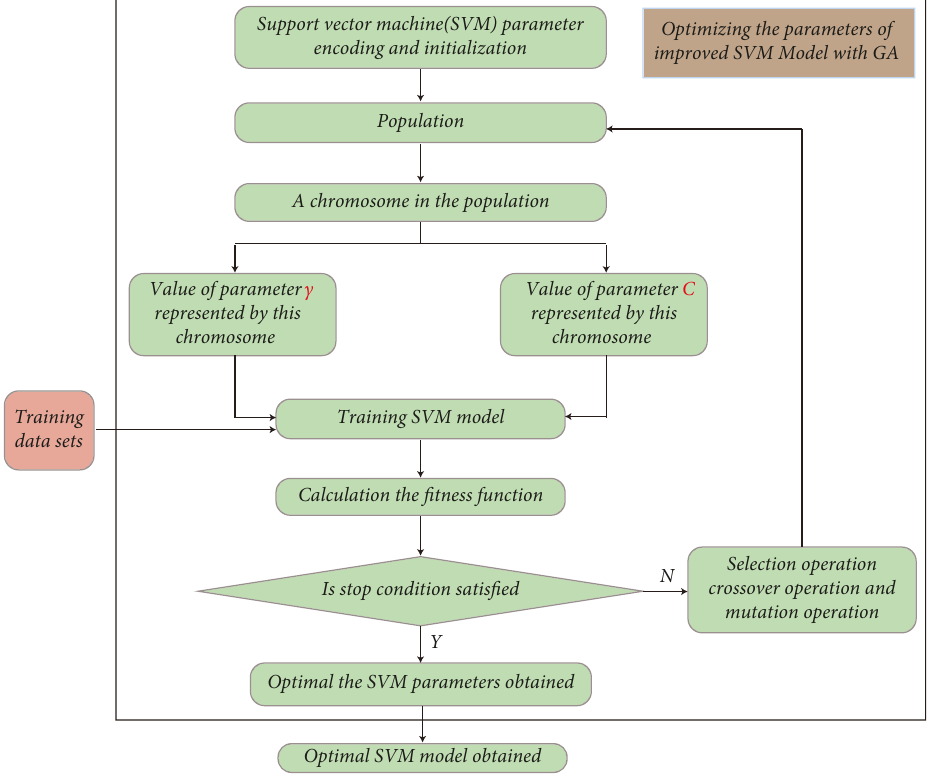
Figure 5: Optimizing the parameters of improved SVM with Table 1: Train sets and test sets.